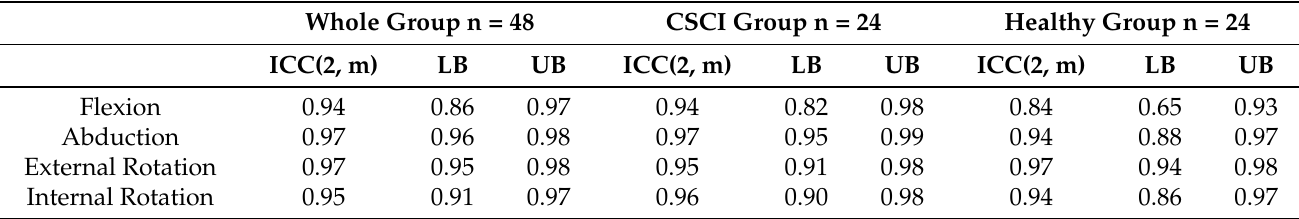
Table 5. Inter-rater reliability indicators for two raters and two inertial measurement units (IMUs) measurements as four different judges, it calculated as ICC(2, m) with m = 4 and the confidence interval is